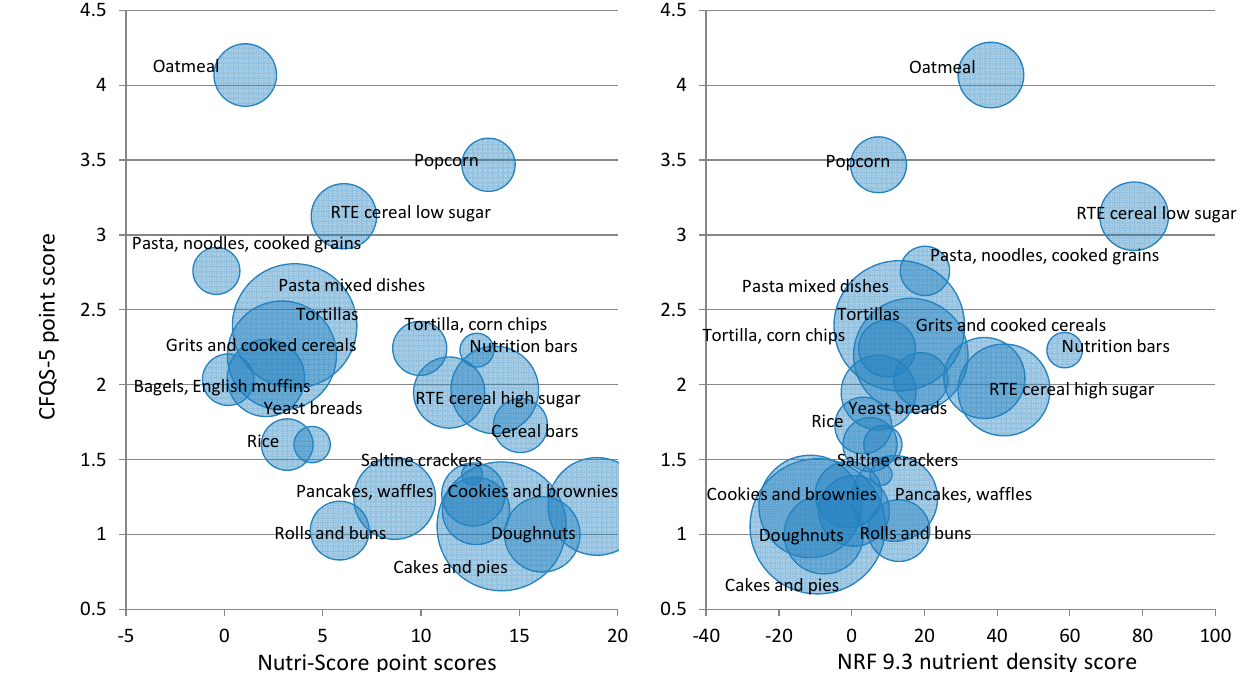
Figure 5. Relation between CFQS-5 Model, Nutri-Score and NRF9.3. (The size of the circles represents the number of higher-quality carbohydrate foods in each food category).